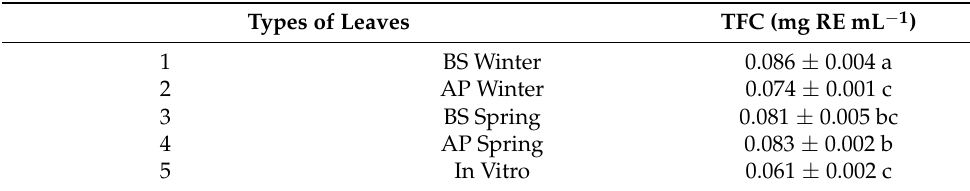
Table 5. Total flavonoids content (mg rutin equivalents per mL) in ex vitro and in vitro leaves of A. chilensis